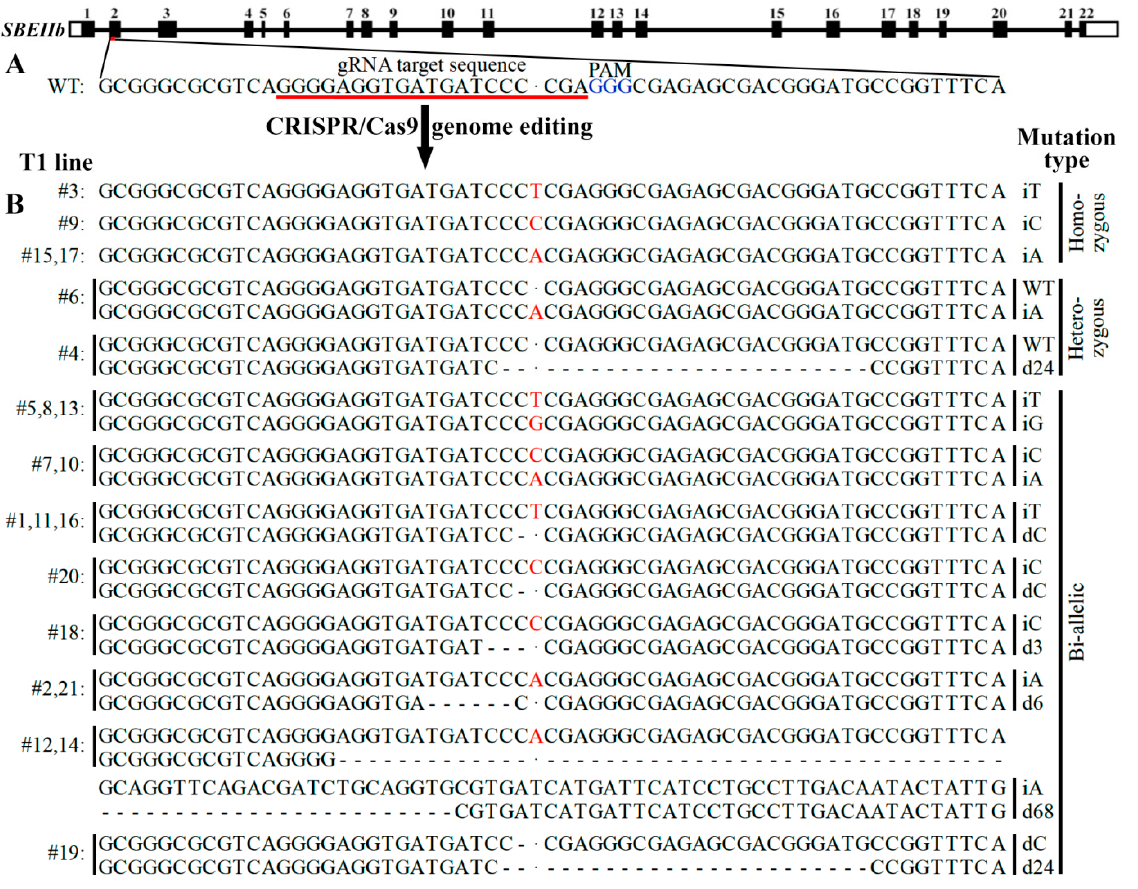
Figure 1. CRISPR/Cas9 induced mutation in SBEIIb gene and mutation types of T1 lines. ( A ) A schematic map of the gRNA target sites on the genomic regions of SBEIIb . The introns are shown as lines, and the exons are shown as boxes. ( B ) Sequencing results of T1 mutant lines. The inserted nucleotide is highlighted in red, and the dashes indicate deletions.